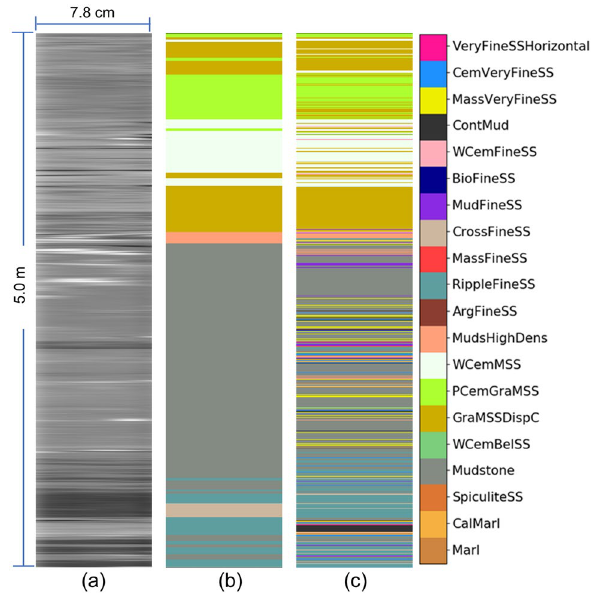
Fig. 13 Lithofacies prediction results from a section of the test set. a 2D whole core CT image, b Lithofacies classes from manual core description, c Lithofacies prediction using the trained CNN classifier